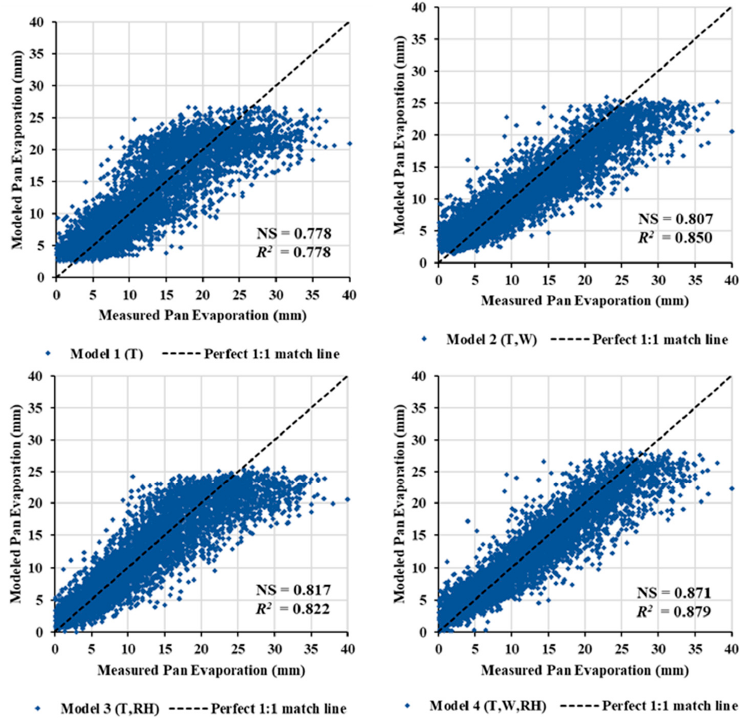
Figure 5. Modeled versus measured pan evaporation depths (mm) for the training period at KIA weather station. T: average daily temperature; RH: average relative humidity; W: average wind speed.